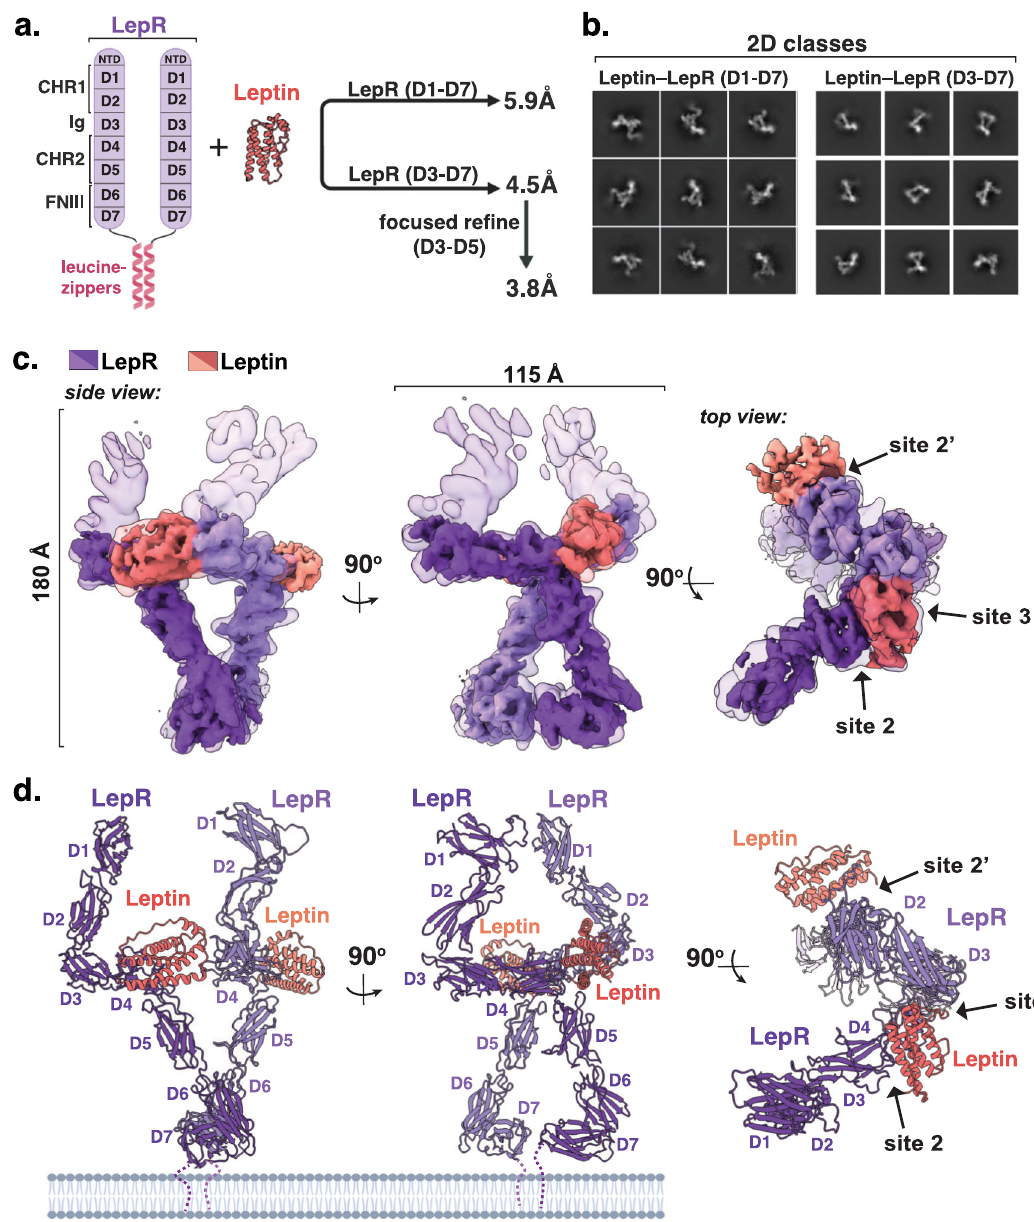
Fig.1|Cryo-EMstructureoftheleptinreceptorsignalingcomplex.a Schematic depicting LepR ECD domain architectures, and the regions analyzed for